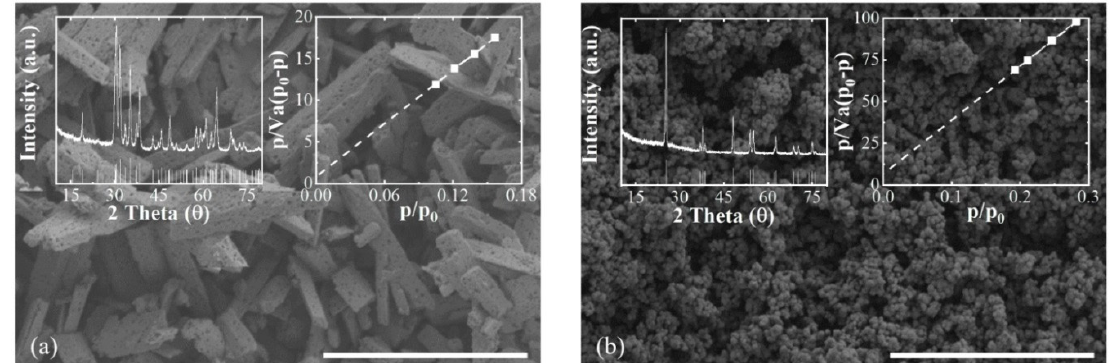
Figure 1. SEM images of ( a ) Ga 2 O 3 and ( b ) TiO 2 photocatalysts (scale bar: 5 µ m). In each image, the upper left and right insets show the XRD pattern and Brunauer–Emmett–Teller (BET) surface area plot, respectively. The bottom tick marks in the XRD indicate PDF Card No. 00-043-1012 for monoclinic Ga 2 O 3 and PDF Card No 00-002-0406 for anatase TiO 2